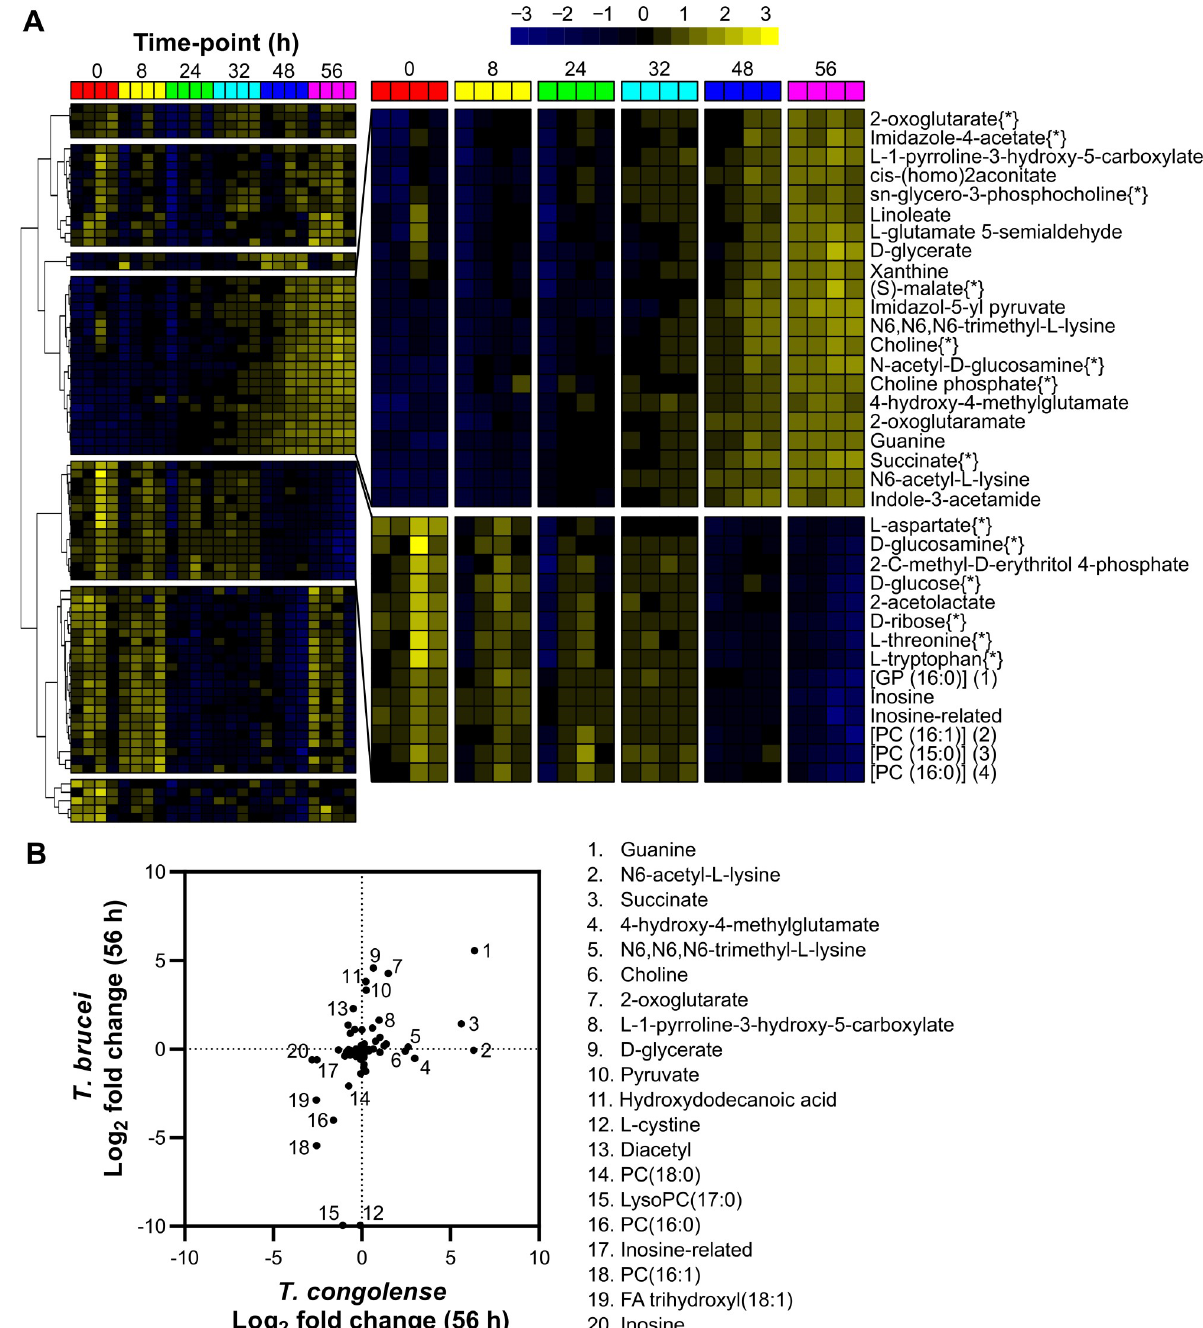
Fig 2. Analysis of supernatant metabolites after T . congolense culture. A heatmap covering the 80 putative medium components judged to be significantly altered after 56 hours of in vitro cell culture containing T . congolense strain IL3000, as calculated by a one-way repeated measures ANOVA ( P < 0.05). Peak abundances were log transformed and mean centred and metabolites were clustered based on Pearson correlation. Two clusters of interest were identified, which are shown in a larger format on the right. Metabolites in the top cluster were observed to increase significantly over time, whilst those in the bottom cluster decreased. Metabolite names followed by { � } were matched to an authentic standard and all other identifications are putative based on mass, retention time and formula. B) Comparison of metabolite changes in medium supernatants after 56 hours between T . brucei [60] and T . congolense (S3 Table). Relative changes in metabolite abundance were calculated as log 2 fold change of 56 h vs 0 h and metabolites exhibiting differences between the species are listed next to the figure.